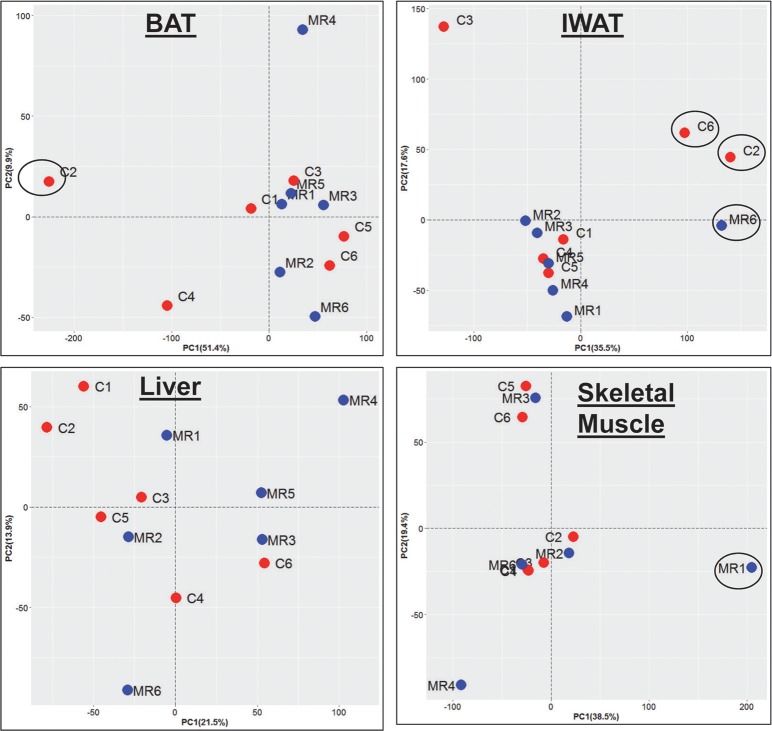
Principal components analysis on SAGE data.PCA was performed on DESeq2 generated signals from IWAT, liver, BAT and skeletal muscle after retaining genes with minimum tag count ≥20 (≥18 for muscle) in at least one sample in each tissue. The first two principal components are plotted, and the proportion of variance explained by each component is indicated on the respective axis titles. Control samples are shown in red and MR-treated samples are shown in blue. The circled samples represent outliers and were removed from further analysis.